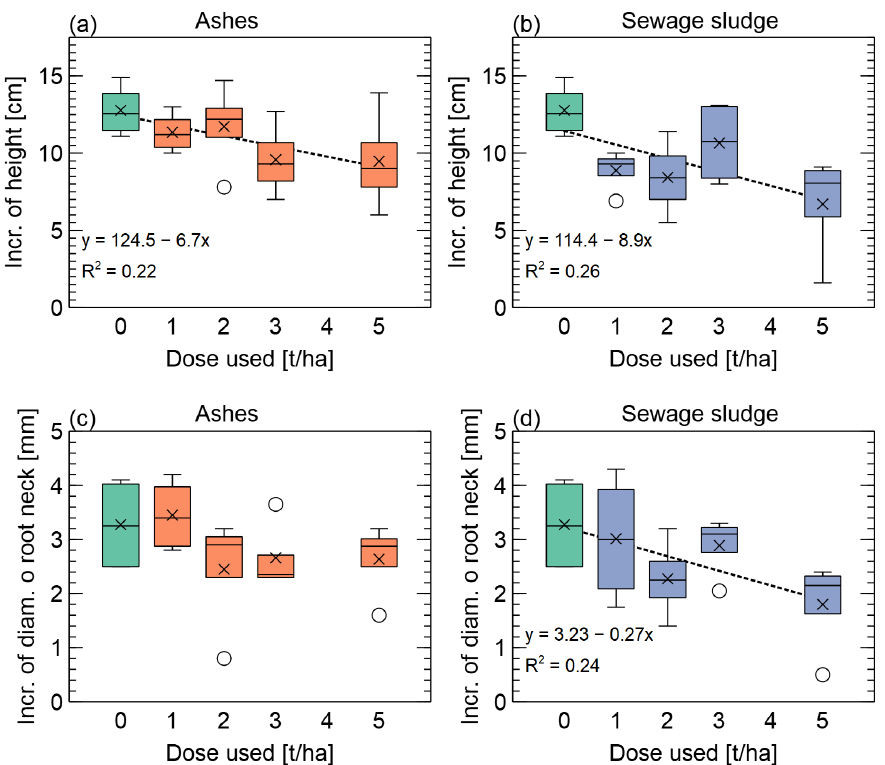
Figure 4. Increase of seedlings’ lengths ( a , c ) and diameter of root neck ( b , d ) versus preparation doses. Two studied variants of mixture with ashes ( a , c ) and sewage sludge ( b , d ) are presented. The dashed lines represent the linear regression fits of the data. The regression equations with the fitted parameters and the models’ R 2 values are printed in subfigures. The results of regression analysis are presented only for the cases when the regression parameters are statistically significant at p < 0.05. In the plot, boxes span from 1st to 3rd quantile, with the median indicated by a line, whiskers indicating 1.5 inter-quantile range, the × symbol mean value, and circles outlier observations.